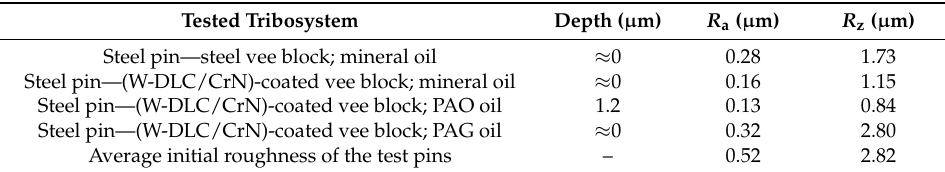
Table 2. The average depths of the wear tracks on the test pins and the surface roughness of the worn area, measured by R a and R z parameters—stylus profilometry